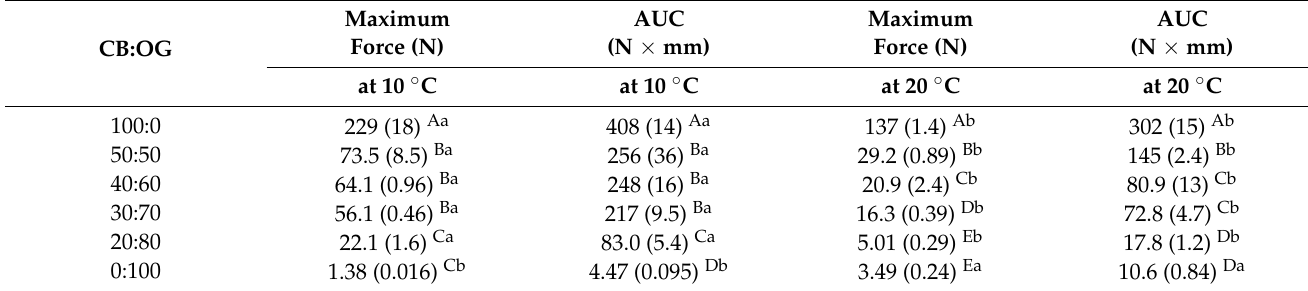
Values are given as mean (n = 6); values in parentheses are standard deviations. A–E Effect of CB replacement percentage. For each textural parameter and the same temperature (10 and 20 ◦ C), mean values without the same letter are significantly different ( p < 0.05). a,b Effect of temperature. For each textural parameter and the same CB replacement percentage (0, 50, 60, 70, 80 and 100%), mean values without the same letter are significantly different ( p < 0.05). AUC: area under the force-distance